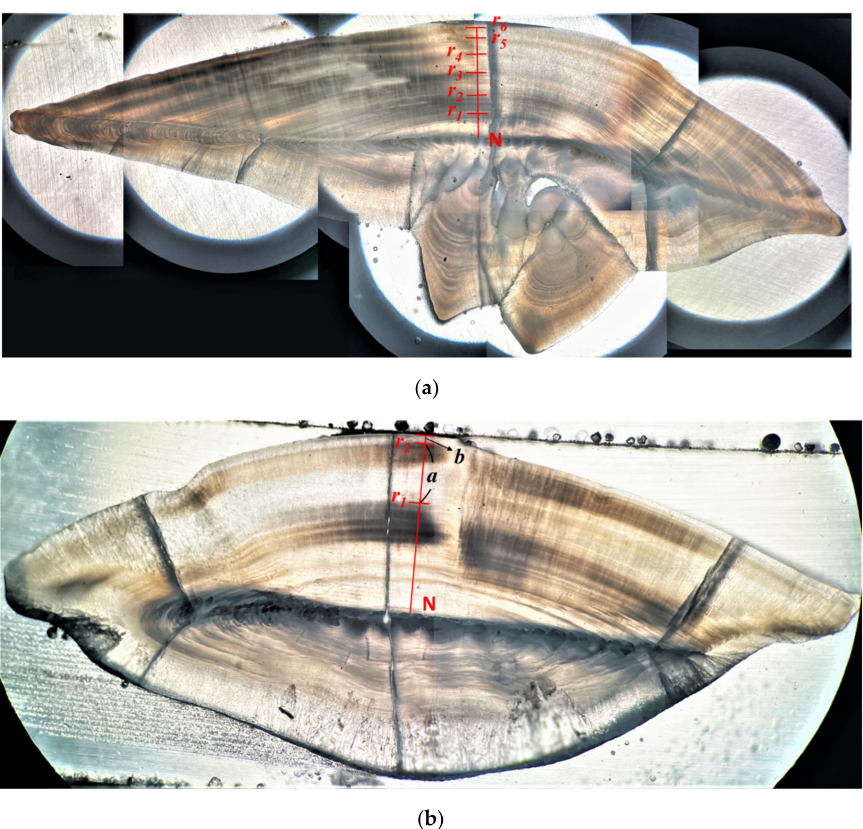
Figure 3. Sample images of sagittal otolith (transverse sections) showing the determination of ages by different methods. ( a ) Integral counting method (sample of A. nibe ; total length 41.5 cm): r n indicate the ring marks on the outer margin of the opaque bands used for determining age class n . (N: nucleus). For this case, the age is six. ( b ) Quartile of marginal growth band method (quantile method, sample of P. macrocephalus ; total length 16.8 cm): r 1 and r 2 indicate the ring marks on the outer margin of the opaque bands. a is the width of the most recent formed annulus, and b is the width of the hyaline band extended from the margin of the outmost opaque band to the edge. Ages were determined as the number of opaque bands plus approximate quartile value of b against a. For this case, the age is